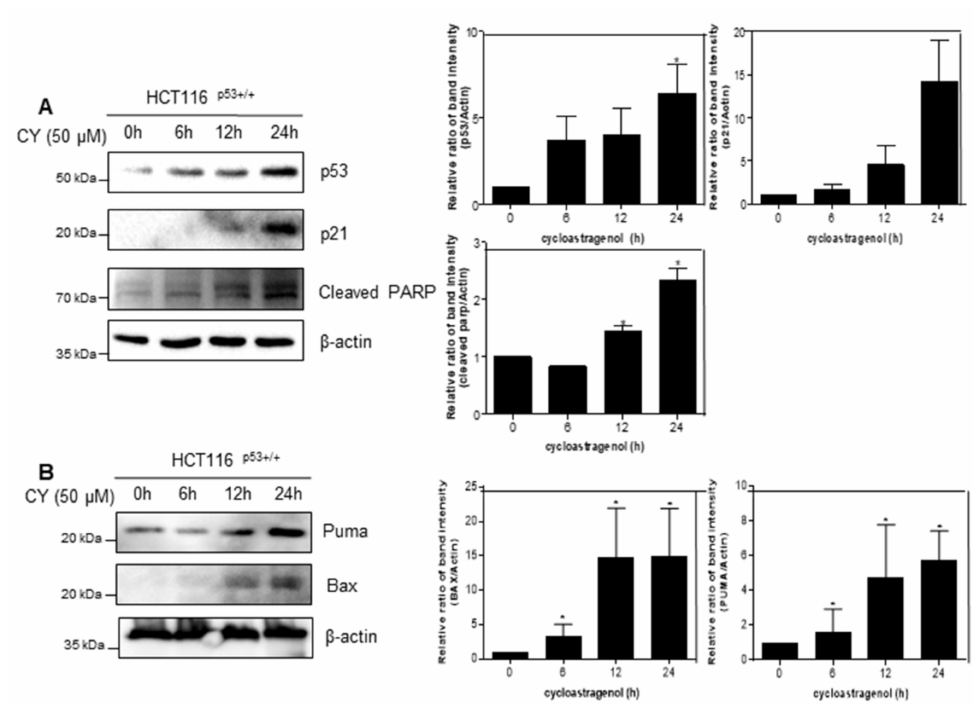
Figure 3. EffectofCYonexpressionofp53andtheirtargetgenesinHCT116 p53+/+ cells. ( A , B )HCT116 p53+/+ cells were treated at 50 µ M CY at various points (0, 6, 12, 24 h) where Western blotting was performed for p53, p21, truncated PARP, Puma, Bax, and β -actin antibodies. Ratio of each protein was determined by Image J. * p < 0.05.